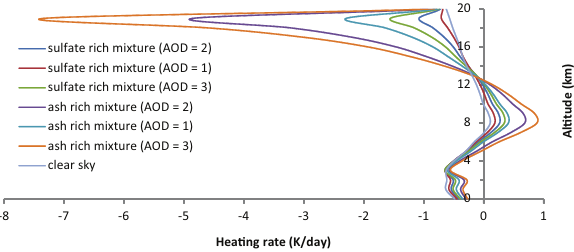
Fig. 14. The effect of aerosol composition and AOD(550nm) of a thick plume ( ∼ 3–20km) on LW cooling